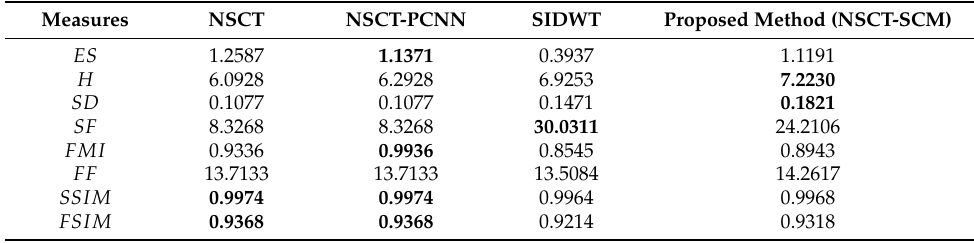
Table 2. The evaluation results of the ROI in Figure